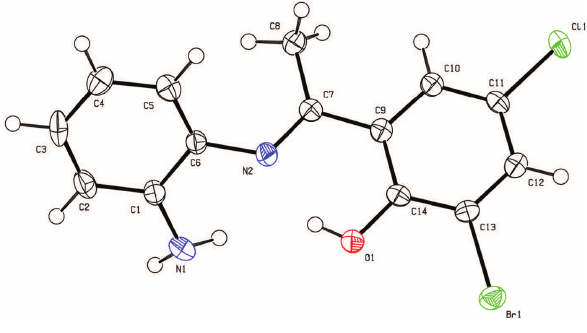
Table 1: Data collection and handling.